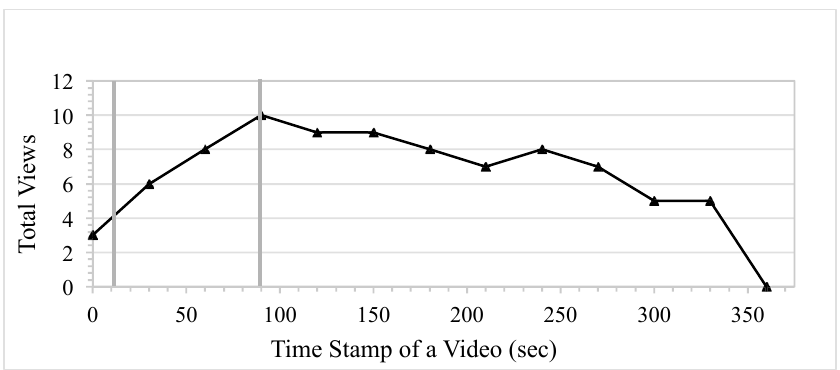
Fig. 6. Total Views vs. time plot for Lecture 35 (Failure of Brittle Materials) The grey vertical lines indicate when a slide